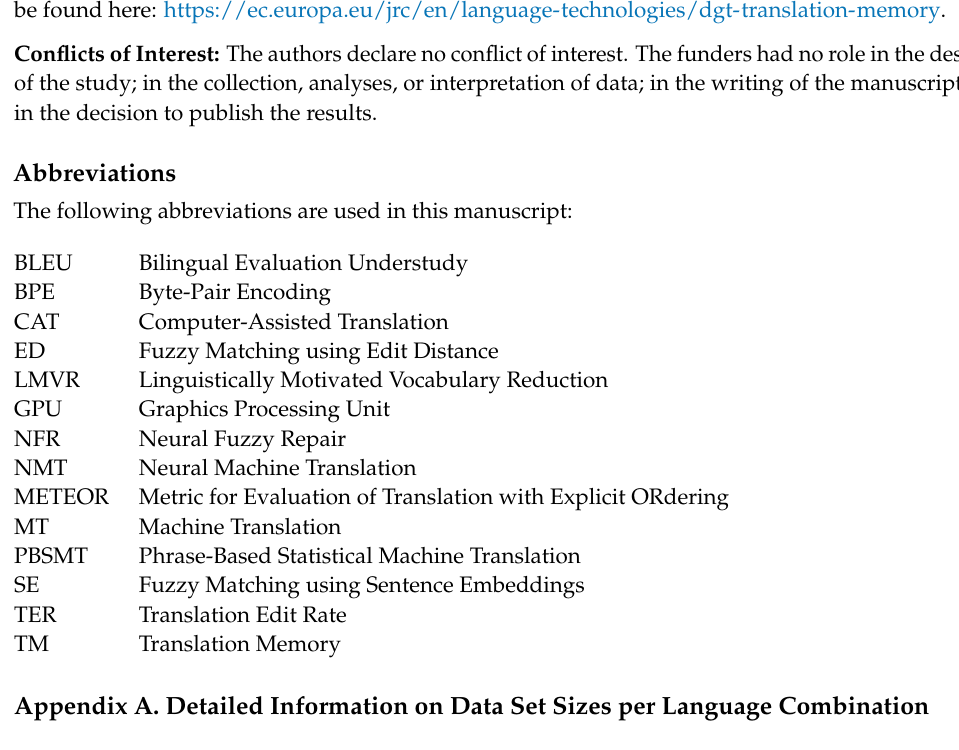
Table A1. Number of sentences in train, validation and test sets, where M stands for millions, and average length of sentences in number of tokens, per language, calculated after